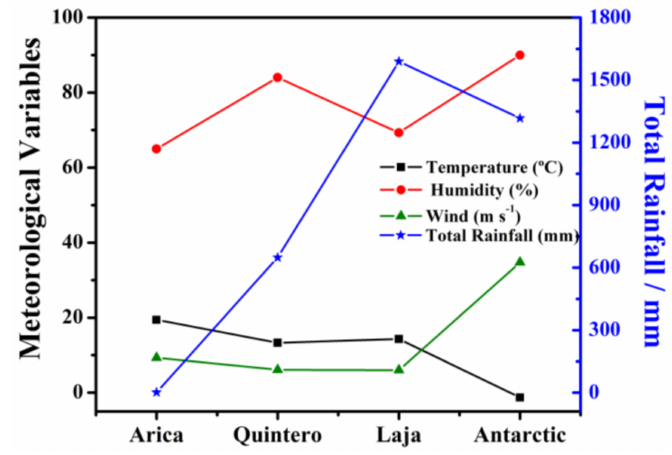
Figure 2. Weather variables measured at test